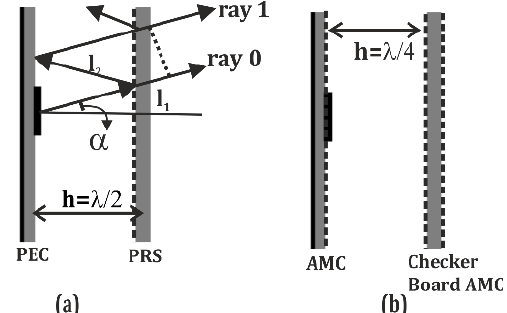
Figure.1. Configuration of cavity antenna (a) PEC ground plane (b) AMC ground plane